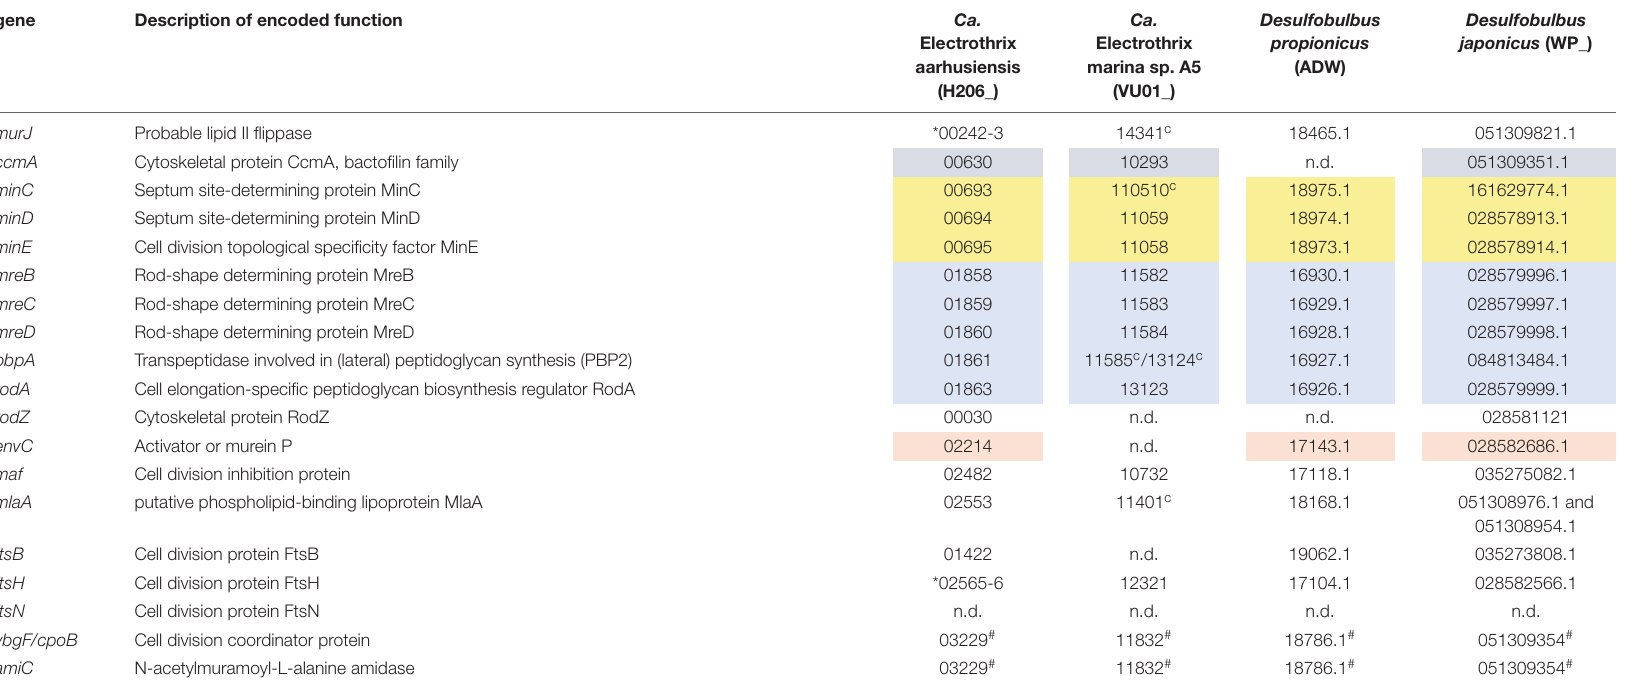
*Indicates the presence of frameshift(s) compared to the gene and its translated protein sequence listed in NCBI with the denoted identifier. # Fused genes. c Genes located at the start or end of a contig, resulting in a partial sequence. n.d., not found in genome. Blocks of the same color denote gene clusters of adjacent genes (including max. 1 gene per cluster putatively encoding a small hypothetical protein). Gene numbering is not necessarily